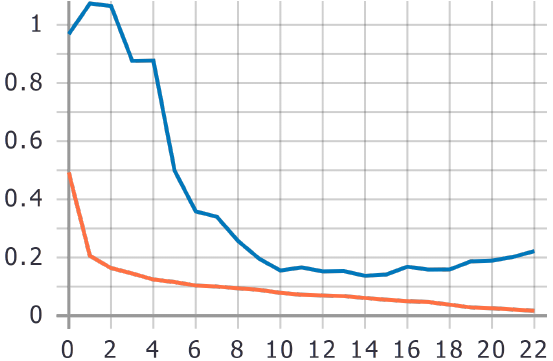
Figure 7. Loss on training and validation data among the epochs.